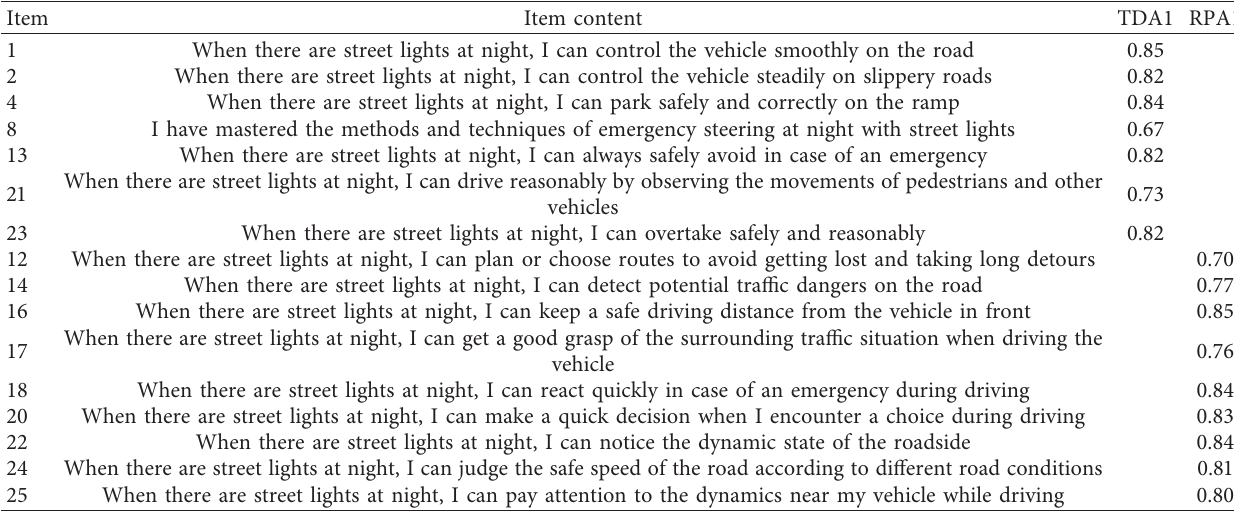
Table 1: Factor structure and load of the driving ability scale in environments with street lights at night. Item Item content TDA1 RPA1